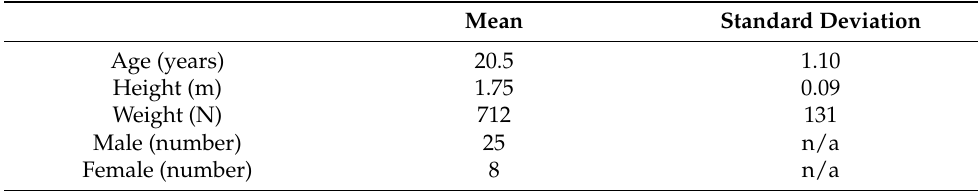
Table 1. Summary of the participants.